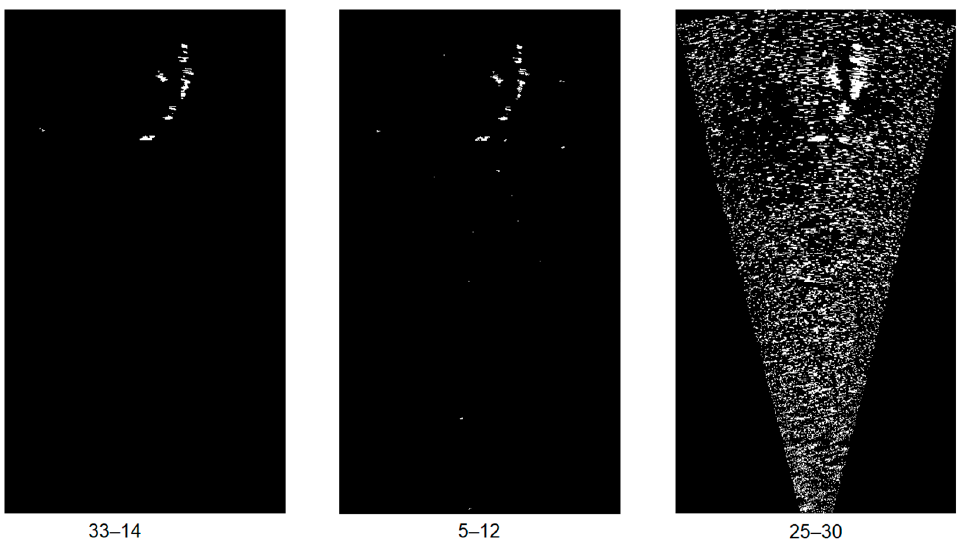
Figure 10. Sample frame of the final resulting target mask, displayed for three different parameter choices for the filter size s f and neighbourhood size s n (displayed beneath each frame in the form s f – s n ).